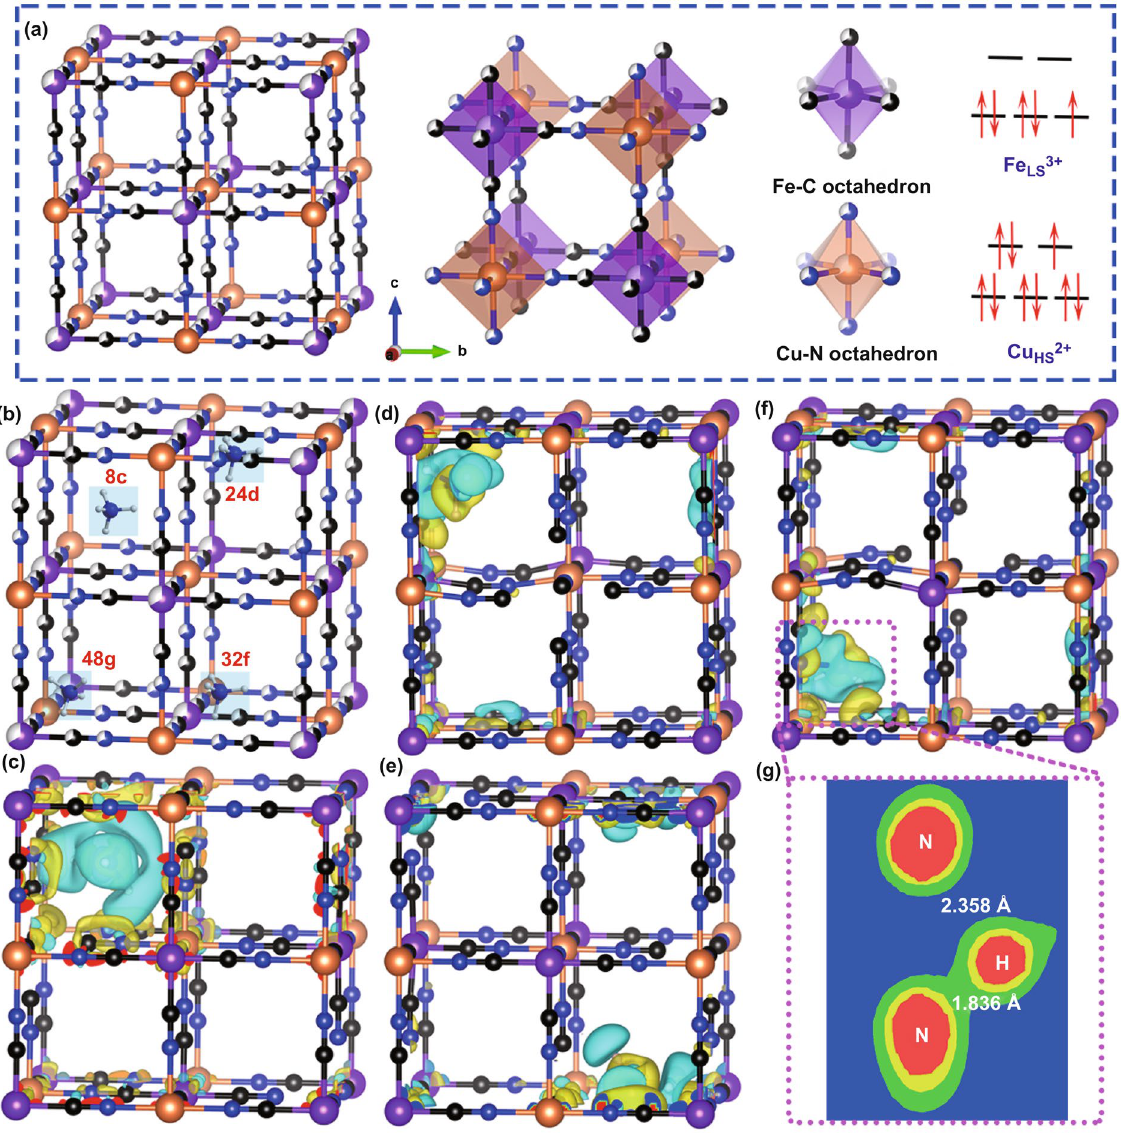
Fig. 1 a Ideal crystal structure of cubic CuHCF and the schematic illustration of the electronic states for Fe and Cu atoms. b Schematic illustra- tion of four possible interstitial positions for NH 4+ storage in CuHCF. c‑f Charge distribution when NH 4+ locates at different sites from DFT calculations. c 8c site. d 24d site. e 32f site. f 48 g site. g Visualized hydrogen bonds and its length when NH 4+ is inserted in 48 g